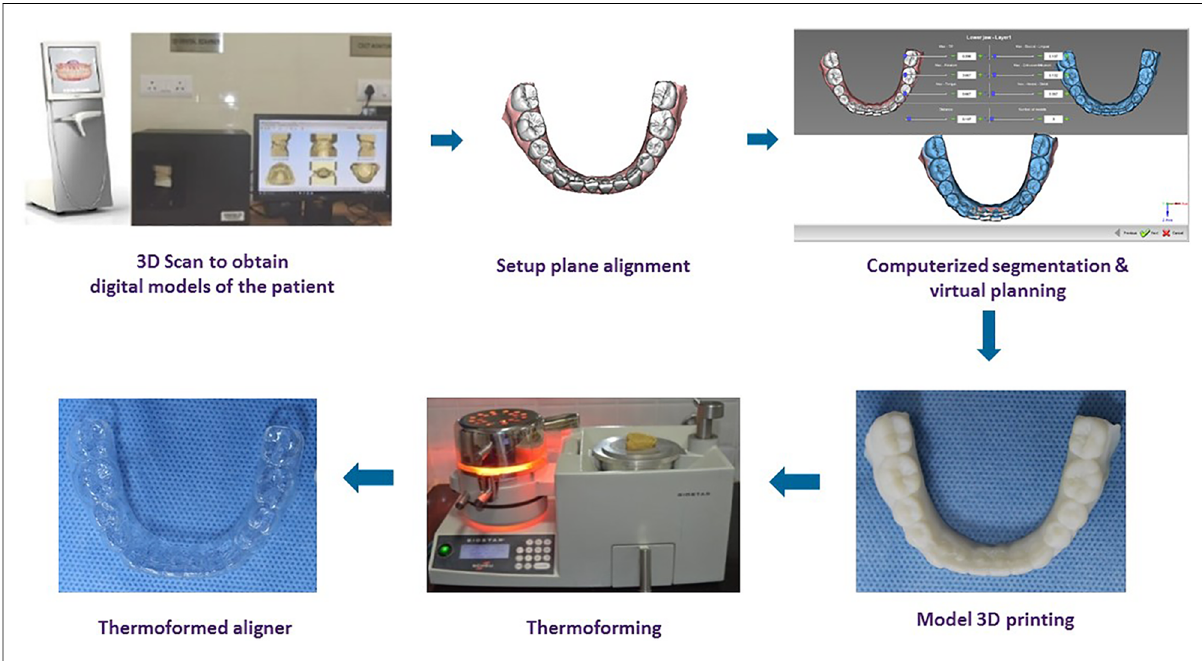
FIGURE 1 The key stages of laboratory procedure in the manufacturing of thermoformed clear